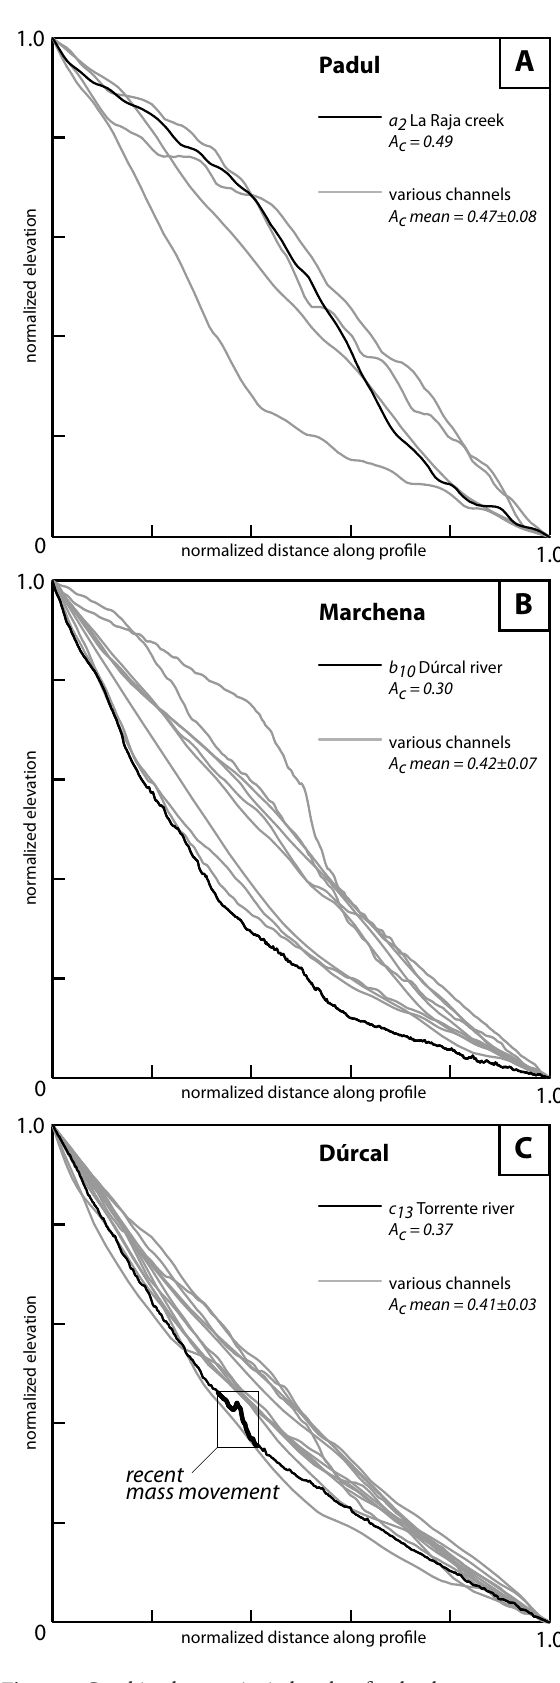
Figure 3. Combined concavity index plots for the three segments of the PNFZ ([A] Padul, [B] Marchena and [C] Dúrcal). One of the , b , c ) is plotted as thick line. used channels for each segment ( a 2 10 13 In the graph, the mean value for all channels of each segment is given. See Figure 1 for location of channels and Table 2 for the de- rived values of A c